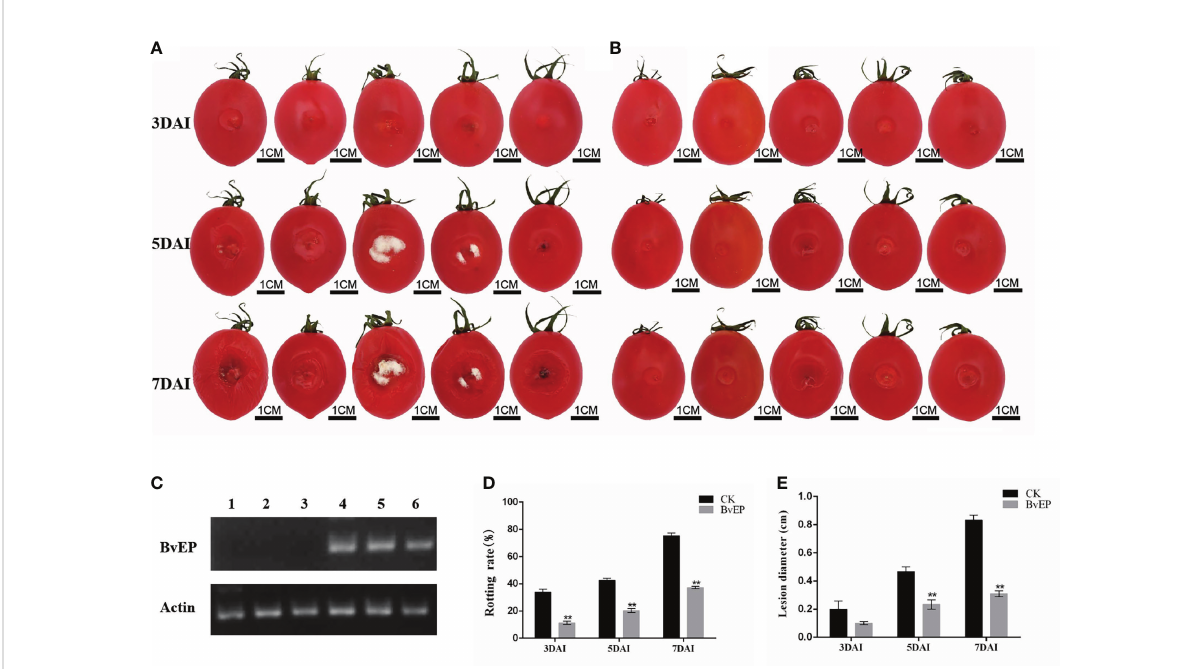
FIGURE 5 Effect of BvEP on resistance to B. cinerea of tomato fruits during storage. (A) The infection process of B. cinerea on tomato fruits after transient transformation with pK7LIC4.0; (B) Infection process of B.cinerea on tomato fruits after transient transformation with pK7LIC4.0-BvEP; (C) Expression of BvEP mRNA in tomato fruits at 3 DAT with pK7LIC4.0 and pK7LIC4.0-BvEP; 1, 2, 3 are pK7LIC4.0; 4, 5 and 6 are pK7LIC4.0-BvEP; (D) Rotting rate of tomato fruits at 3 DAI, 5 DAI, and 7 DAI with B.cinerea ; (E) Lesion diameter on tomato fruits at 3·DAl, 5·DAl, and· 7·DAI with B. cinerea ; asterisks indicate statistically signi fi cant differences (**